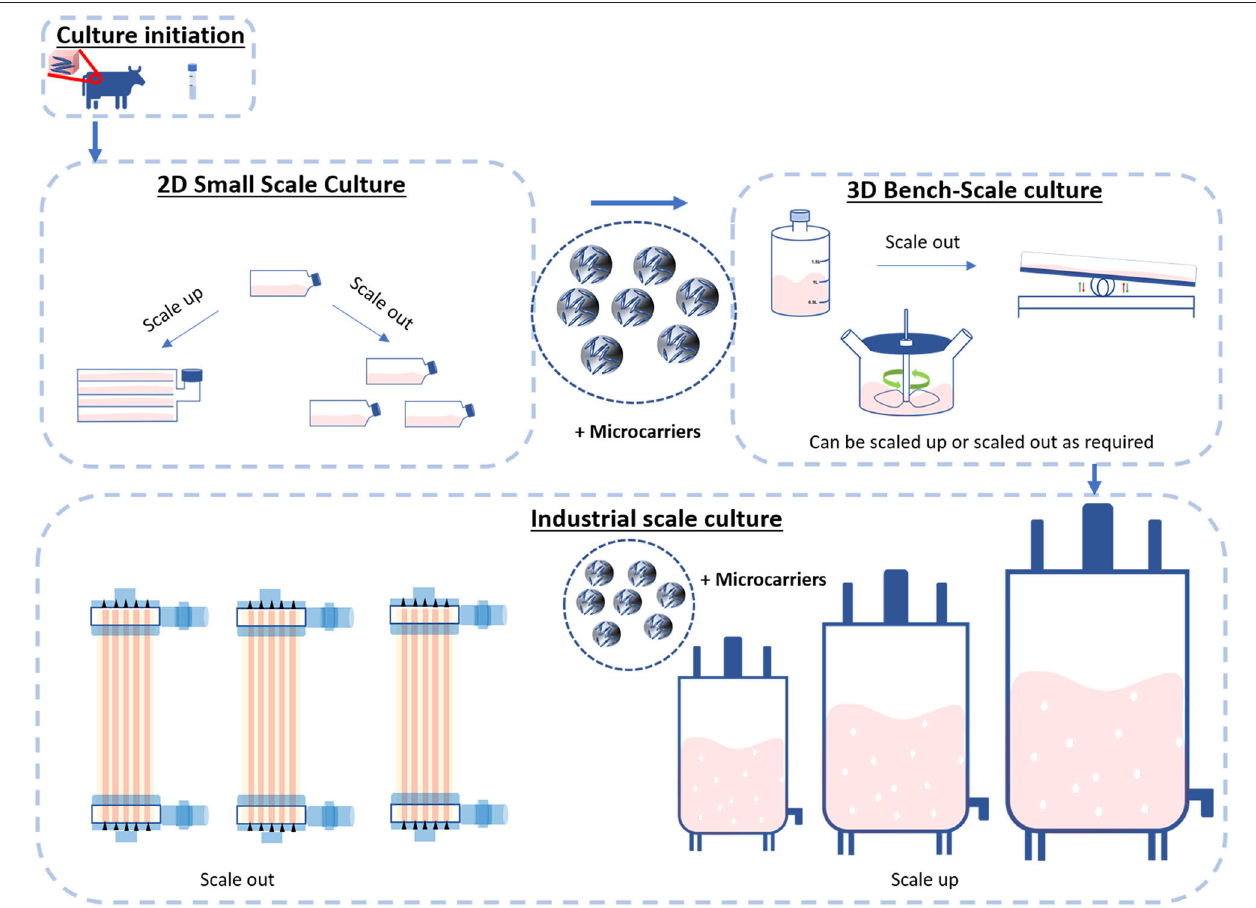
FIGURE 4 | Scale-up and Scale-out. Cultures are typically initiated from cryopreserved stocks or biopsies and cultivated in small-scale cultures such as flasks. These flasks can be scaled up with the use of microcarriers or scaled out with the use of hyper or multilayered flasks. The process then enters the bench scale stage. Here, the use of larger vessels such as roller bottles, perfusion bioreactors and spinner flasks can be deployed to both scale-up and scale-out the process. When required, the process then enters the industrial scale. This stage of bioprocessing enters two distinct streams: bioreactors scale-out (multiple bioreactors of the same size) or scale-up (further processing up to a single